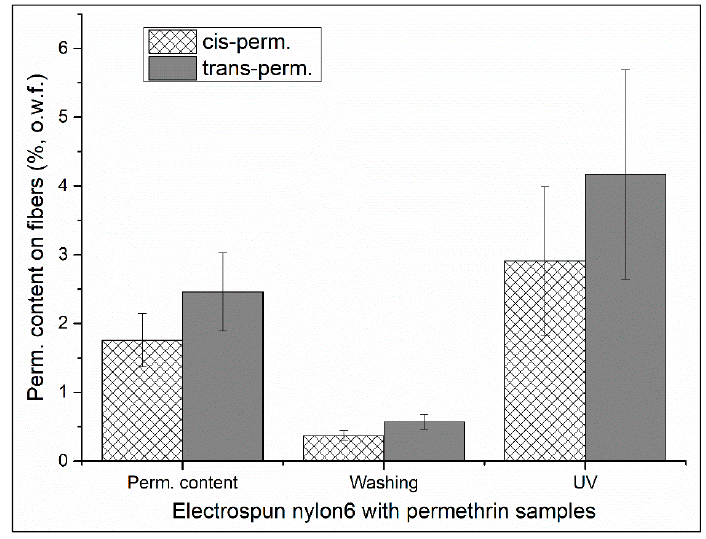
Figure 8. Permethrin contents on electrospun nylon 6 fibers incorporated with 2.5% (o.w.f.) permethrin after formation, after a washing process and after four hours of direct sunlight exposure.